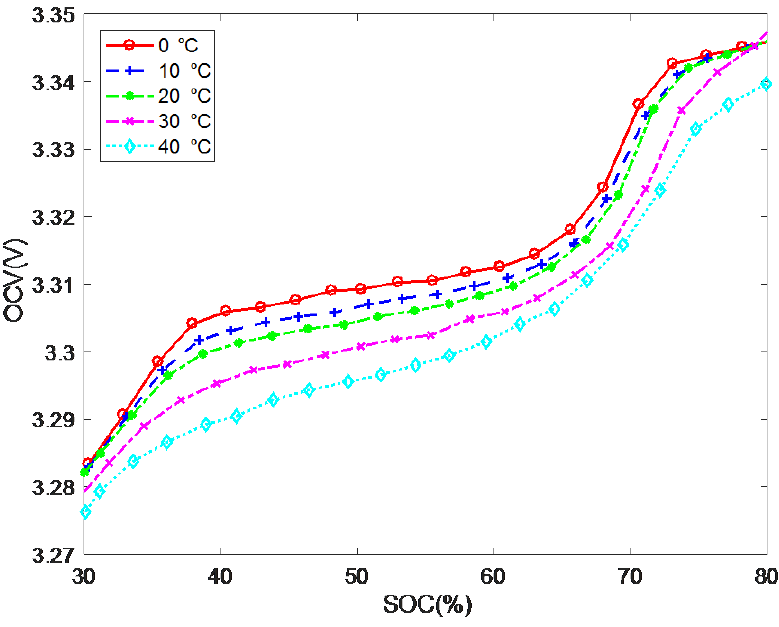
Figure 12. SOC-OCV curves at different temperatures.